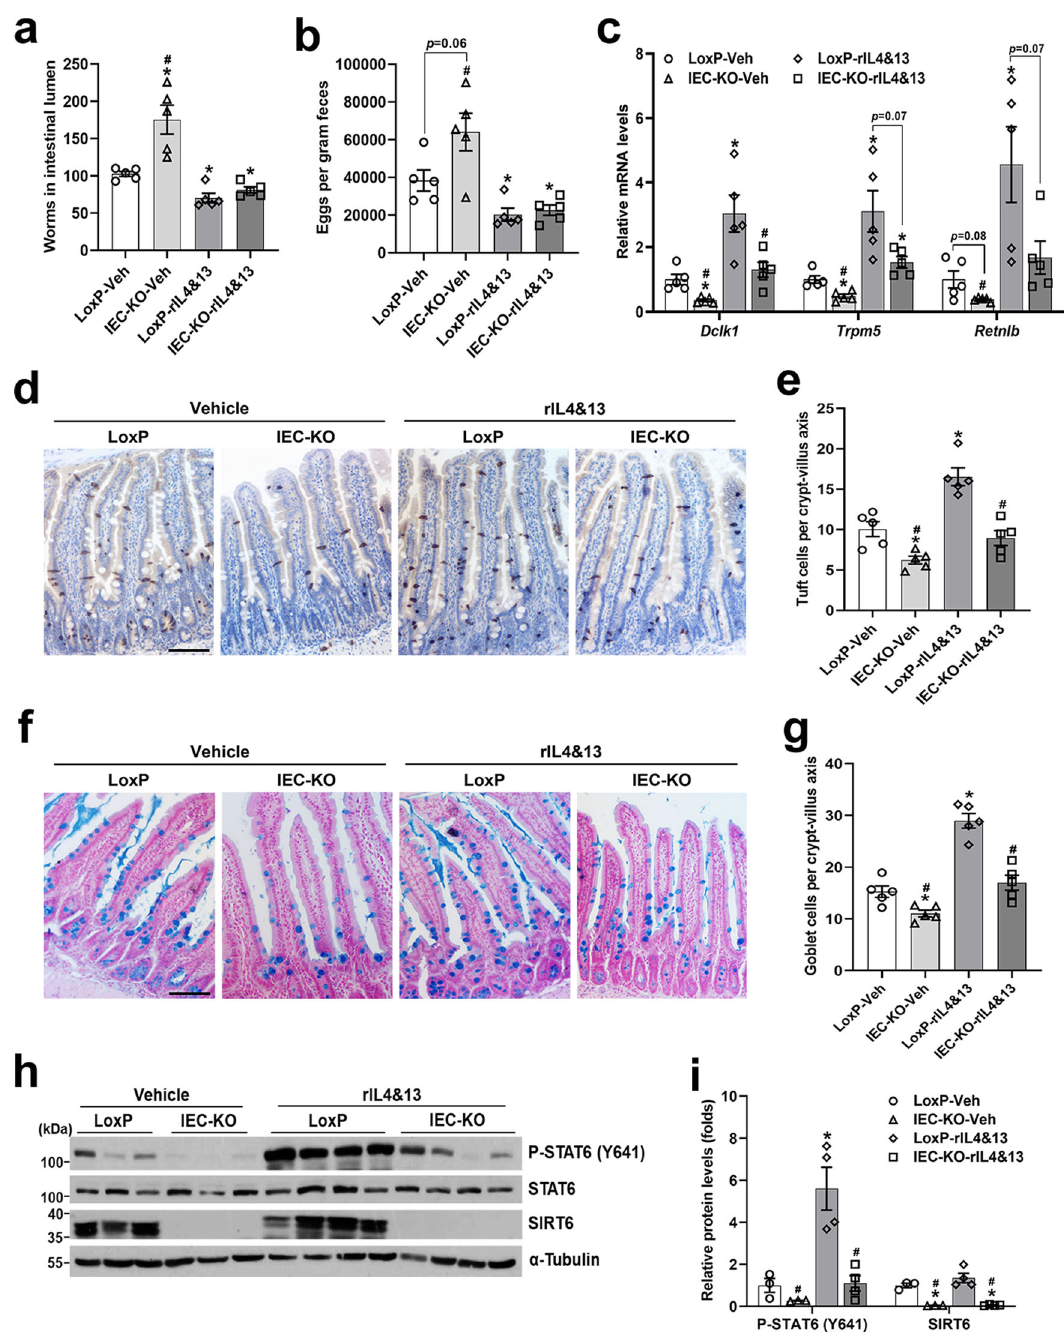
Fig. 2 | Recombinant IL4&IL13 treatment fails to rescue the impaired tuft and goblet cell hyperplasia caused by epithelial Sirt6 ablation. 3-4-month-old male LoxP and IEC-KO mice were injected ( i.p .) daily with vehicle or rIL4&rIL13 (1ug/ mouse)fromday6after H.poly infectionandsubjectedtothefollowinganalyseson day 14 post-infection. a , b Analysis of parasite burden by quanti fi cation of adult worms in intestinal lumen ( a ) and eggs in feces ( b ). n =5 mice/group; form left to right, * p =0.019, 0.0038, 0.0038; # p =0.004 in ( a ); * p =0.03, 0.0466; # p =0.0092 in( b ). c qPCRanalysisoftuftandgobletcellmarkersexpressioninthejejunalIECs. n =5mice/group;formlefttoright, Dclk1 (* p =0.0125,0.021;# p =0.0092,0.0348), Trpm5 (* p =0.0058, 0.0288, 0.0422; # p =0.0144), Retnlb (* p =0.0368; # p =0.0235). d Jejunal tuft cells were examined by IHC staining with anti-DCLK1 antibody (200X). e Quanti fi cation of tuft (DCLK1 positive) cells shown in ( d ). n =5